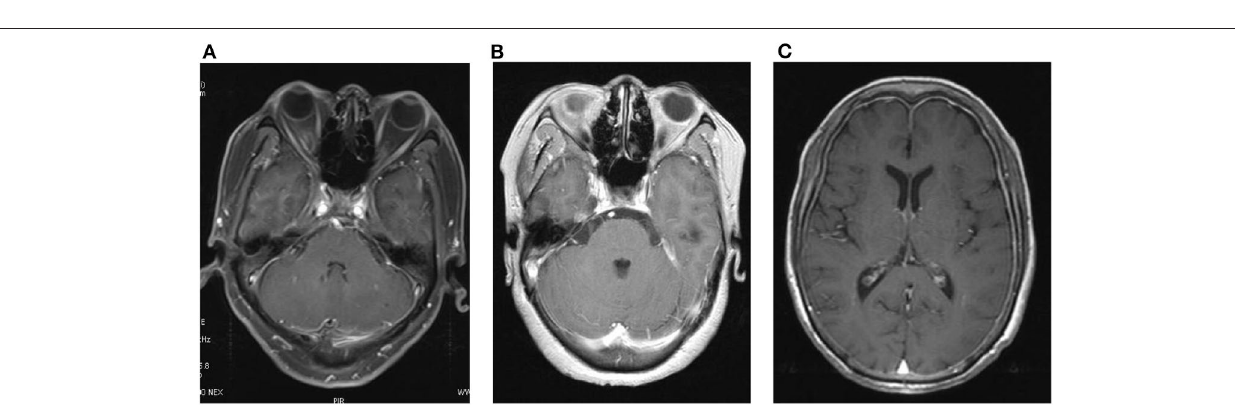
FIGURE 2 | Typical radiology features for HP patients. (A) A 61 year-old man presented with headache and hearing loss. He was diagnosed with idiopathic HP. There was dural enhancement of the posterior fossa in an axial T1-weighted MRI. (B) Axial T1-weighted MRI of a 54 year-old woman demonstrated dural enhancement of the posterior fossa. She was diagnosed with tuberculous-related HP. (C) A 66 year-old woman complained of headache, right hearing loss, and right vision loss for 2 months. MPO antibodies were positive, and a diagnosis of ANCA-related HP was established. The enhanced MRI showed dural enhancement of the frontal, parietal, and occipital